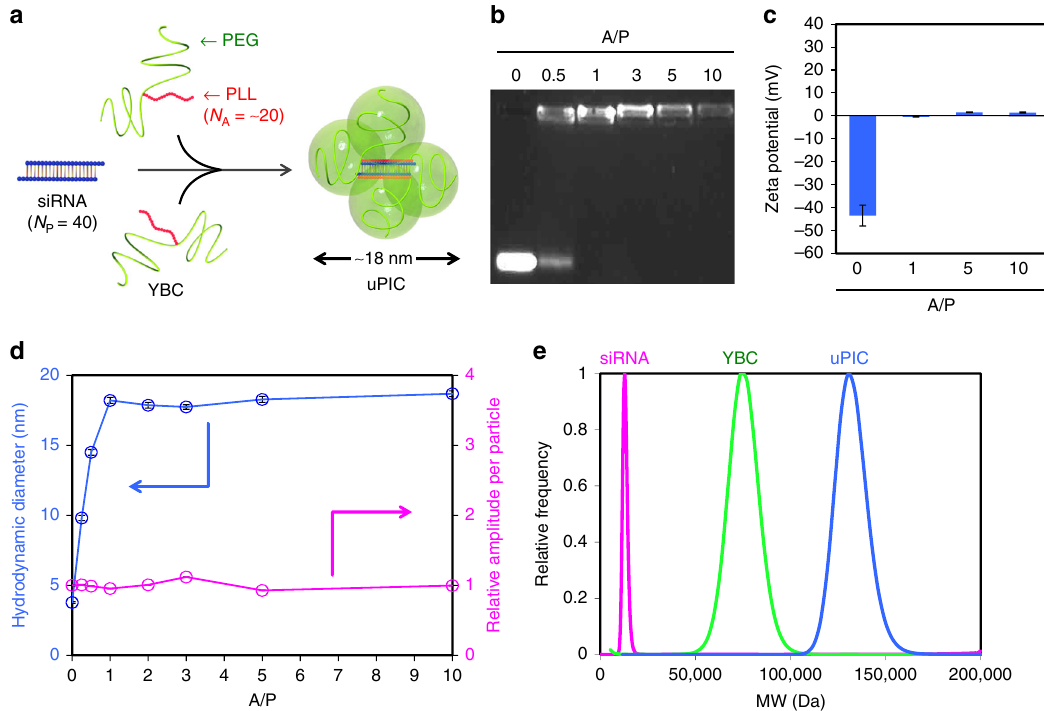
Fig. 1 Construction and characterisation of uPIC from siRNA and YBC. a Schematic illustration of uPIC formation from the single siRNA and the dyad of YBCs through charge-matched ion-pairing. b Agarose gel retardation analysis of PIC samples prepared at varying A/P ratios. c Zeta potentials of PIC samples prepared at varying A/P ratios, determined by electrophoretic laser scattering. Data represent the means ± s.d. for three replicate measurements. d Hydrodynamic diameter of A647-siRNA complexed with YBC at varying A/P ratios, and the corresponding association number of siRNA per PIC, determined by FCS. Data represent the means ± s.d. for fi ve replicate measurements. e Molecular weight histograms of free siRNA, free YBC, and